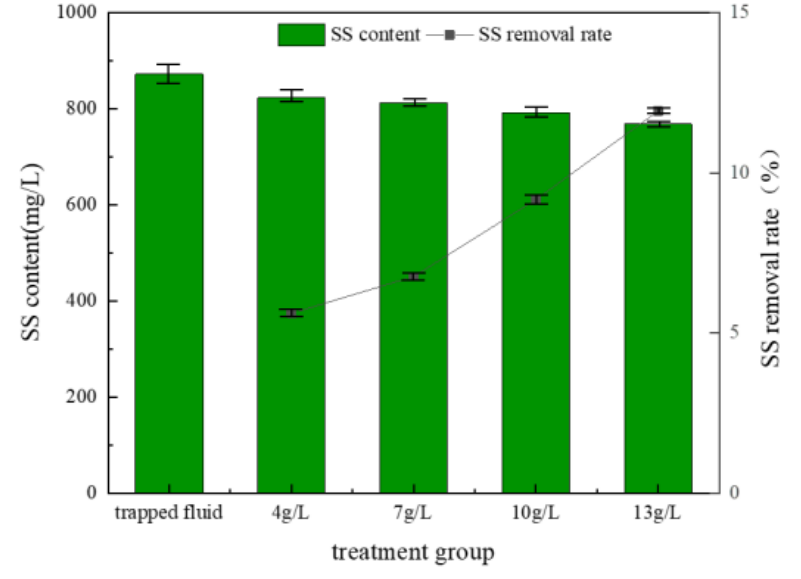
Figure 4. Effects of biochar absorption on